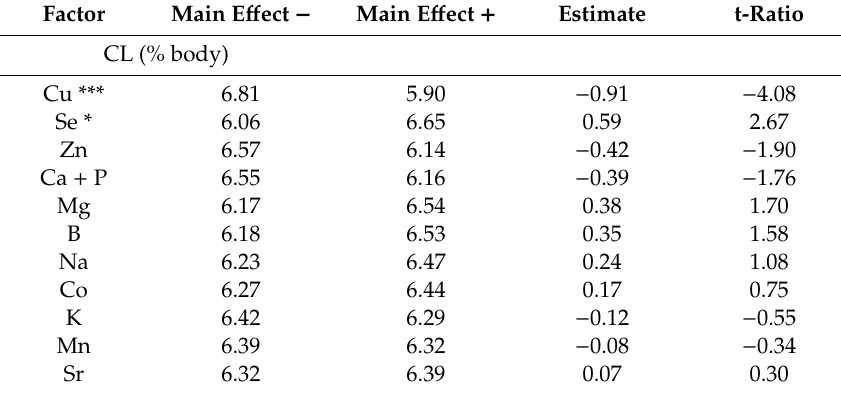
Table A3. E ff ect of twelve dietary minerals at two inclusion levels ( − /+ ) on CL, ash, CP and GE content of prawn bodyes using two-level screening analysis. Factors are sorted by | estimates | and significant factors are marked by an asterisk (* p < 0.05, ** p < 0.01, *** p <